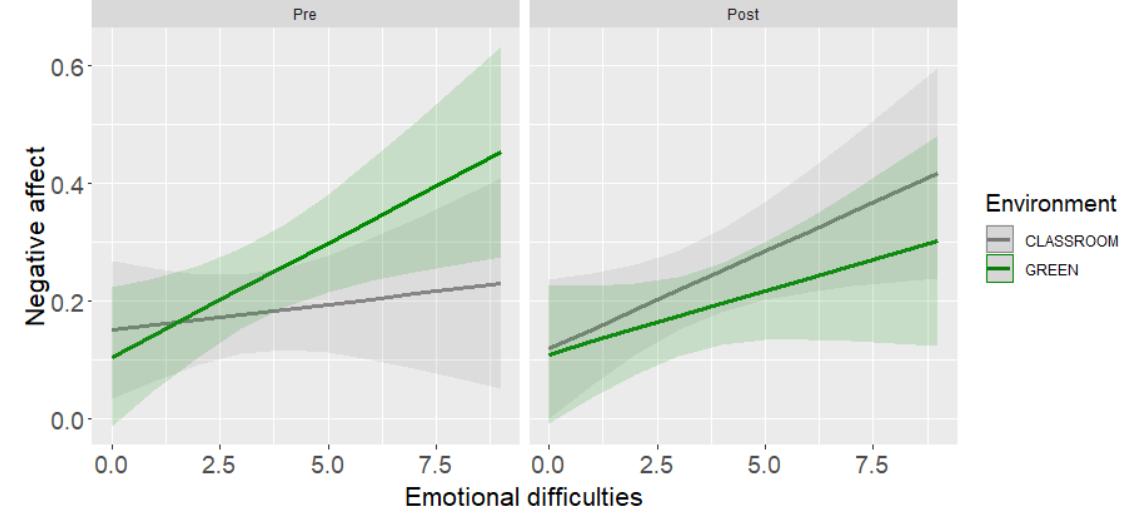
Figure 4. Interaction effect of environment, pre ‐ post negative affect, and emotional difficulties.